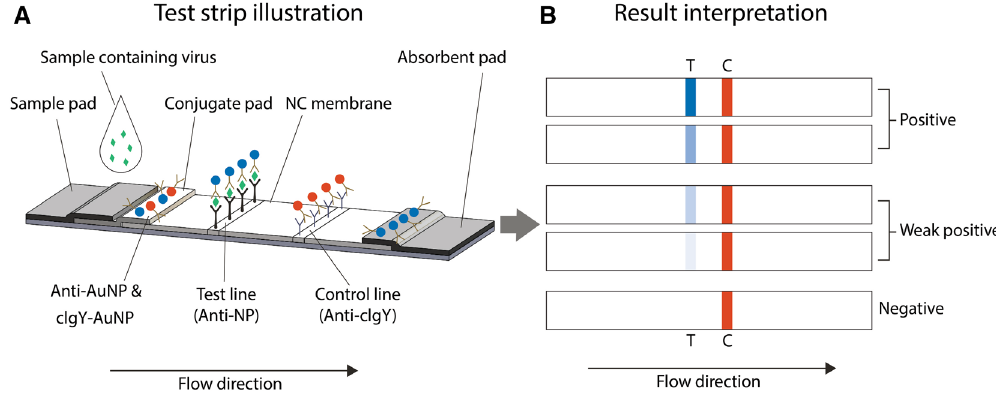
Figure 1. Lateral flow test strip design and assay principle ( A ). Mouse anti-nucleocapsid protein antibody conjugated to 150 nm gold particles (anti-AuNP) are for mouse anti-nucleocapsid protein (anti-NP) test